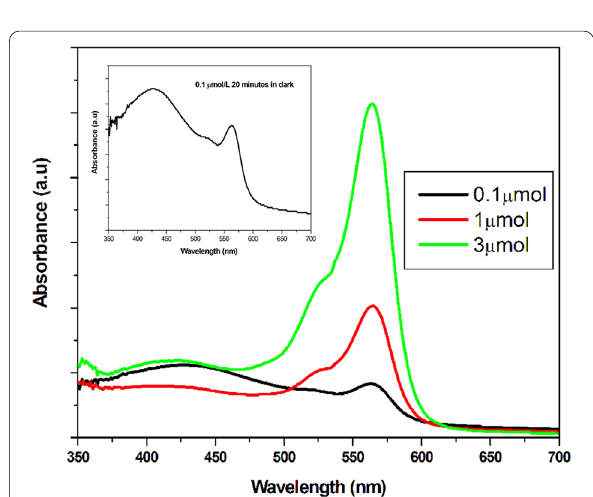
Fig. 11 Optical absorption spectra of mixture of silver nano-particle colloidal solution and 0.1 µmol/L, 1 µmol/L and 3 µmol/L sulforhodamine B dye aqueous solution kept in dark for 5 min